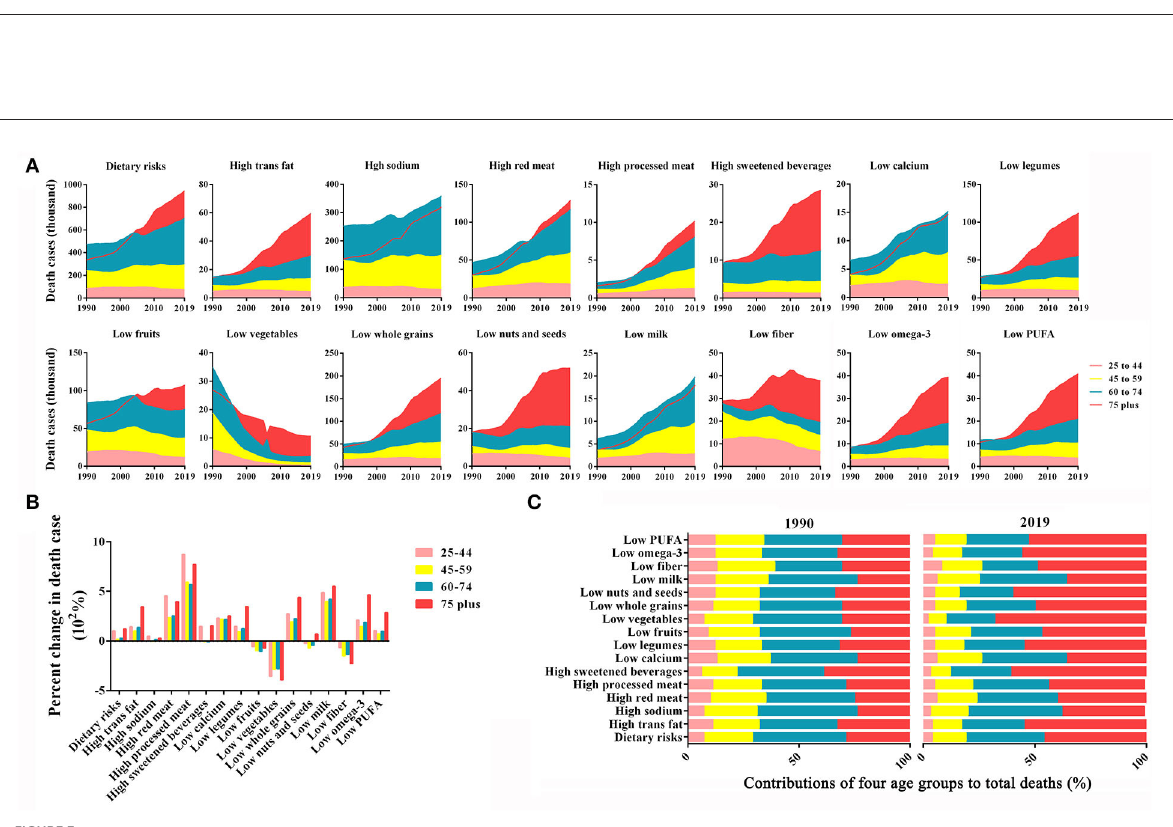
FIGURE3 Burden of dietary risk-related deaths in various age groups of China in individual dietary risk factors from 1990 to 2019. (A) The contribution of each age group to total deaths. (B) The percent changes in deaths in the four age groups. (C) The four age groups as percentages of total